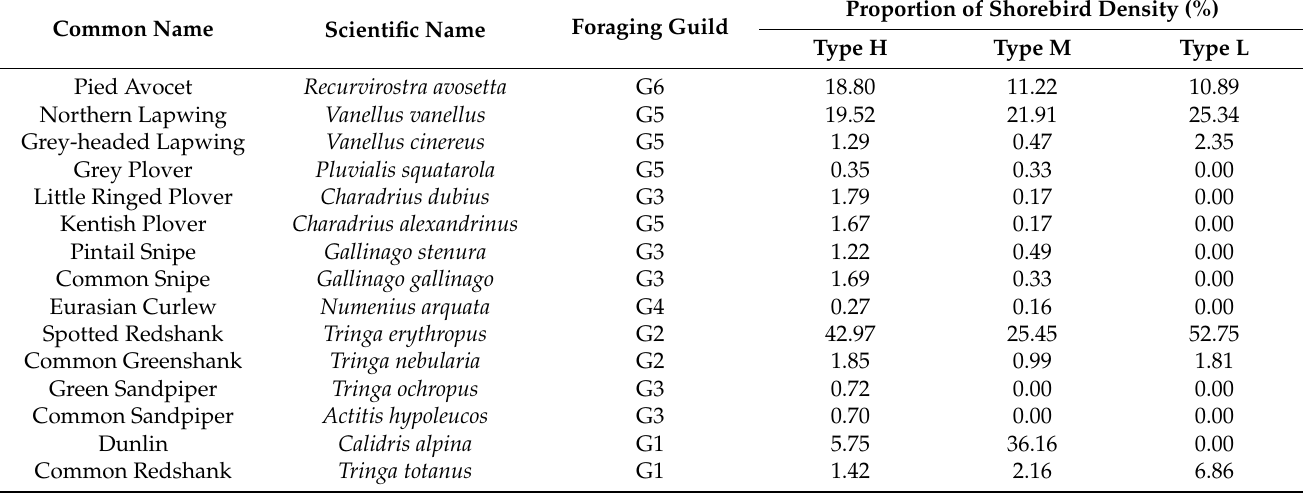
Table 2. The foraging guild to which each species belongs and the density proportion of shorebird species in the different study areas.